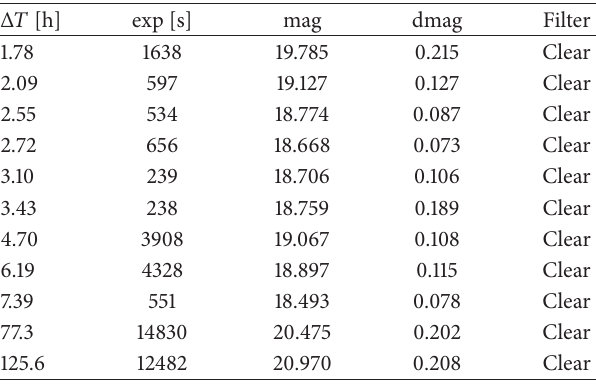
Table 9: GRB 100418A: observing log of BOOTES-2.